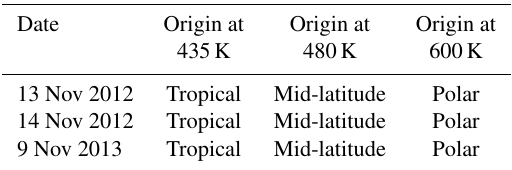
Table 4. Origin of ozone-poor air at isentropic levels for low-ozone events in February.